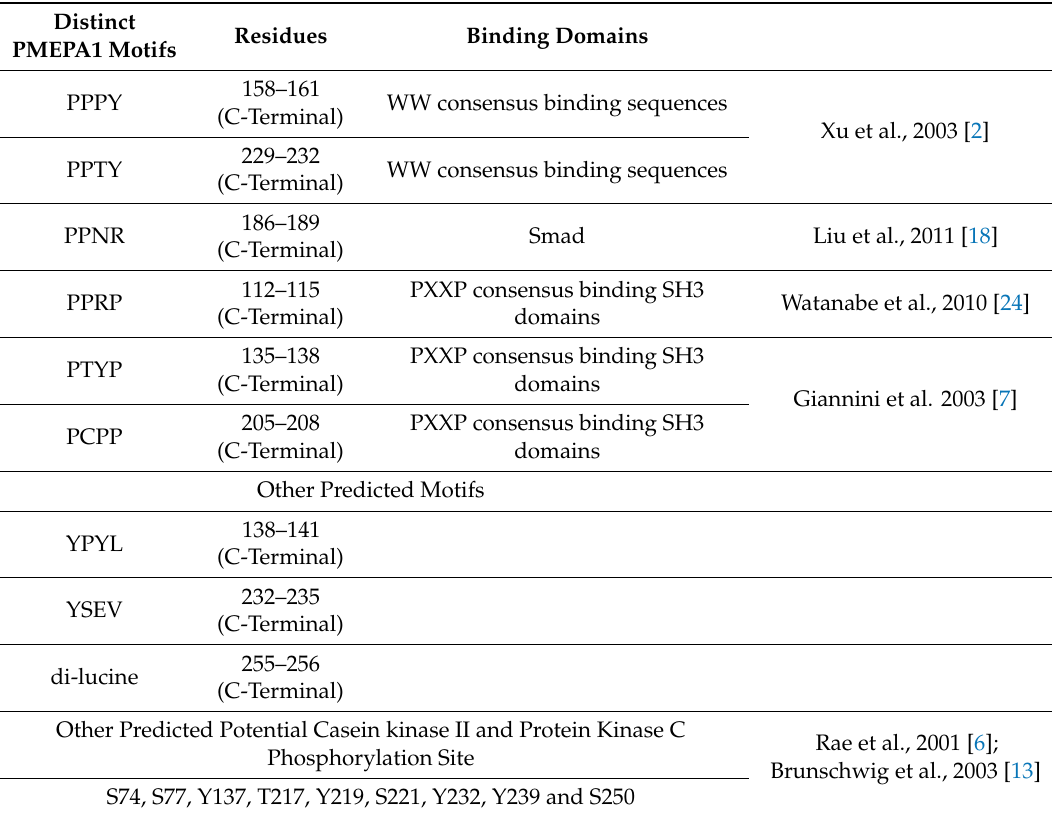
Table 1. Distinct PMEPA1 motifs and phosphorylation